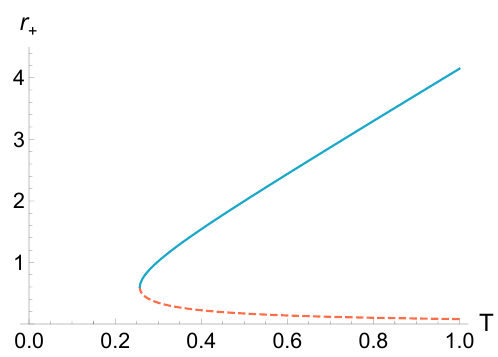
Figure 16 . At fixed angular potential, here Ω + = 0 . 5 and ‘ = 1 , for each value of T there are a small and large black hole branch. Within the physical parameter space of figure 13, there exists a minimum value of the temperature for such black hole